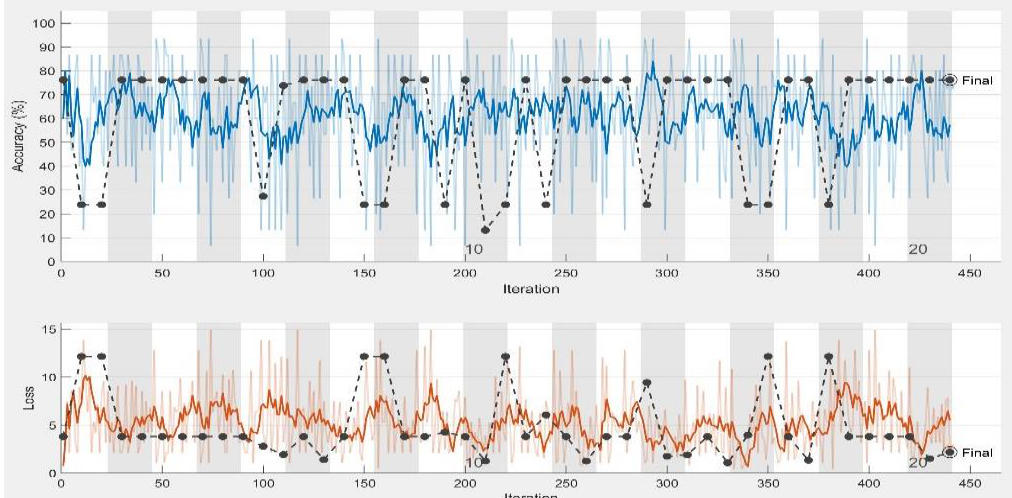
Figure 5. GoogLeNet training process with learning rate of 0.01. The figure shows the epoch number, training accuracy (blue line), validation accuracy (black line), and loss function value for the training data (red line) and validation data (black line).